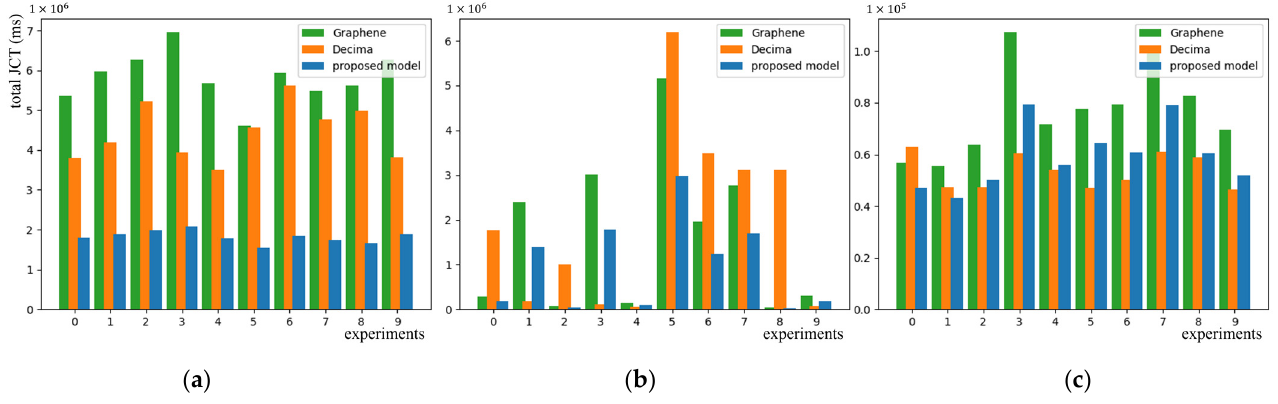
Figure 6. JCT on alidata ( a ), scientific workflows ( b ), and Tpc-h ( c ) using the proposed model, Decima, and Graphene and